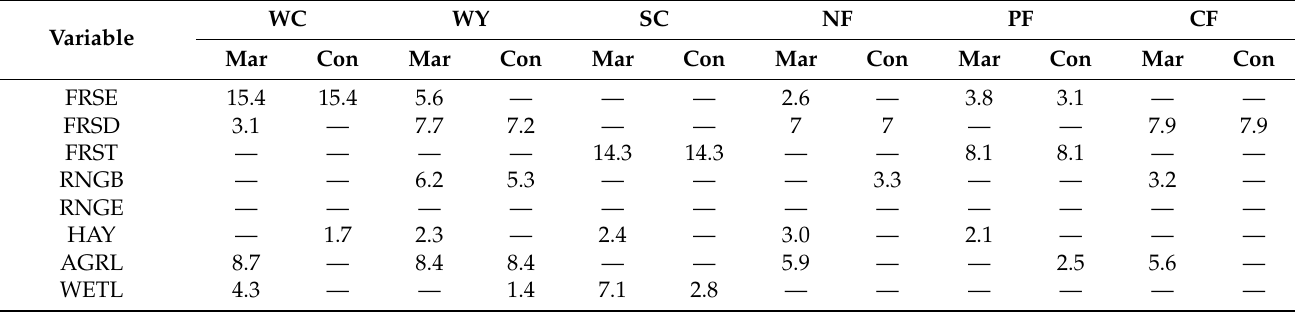
Table 5. Marginal and Conditional Effects from the Summary of Forward Selection for Different ESs.